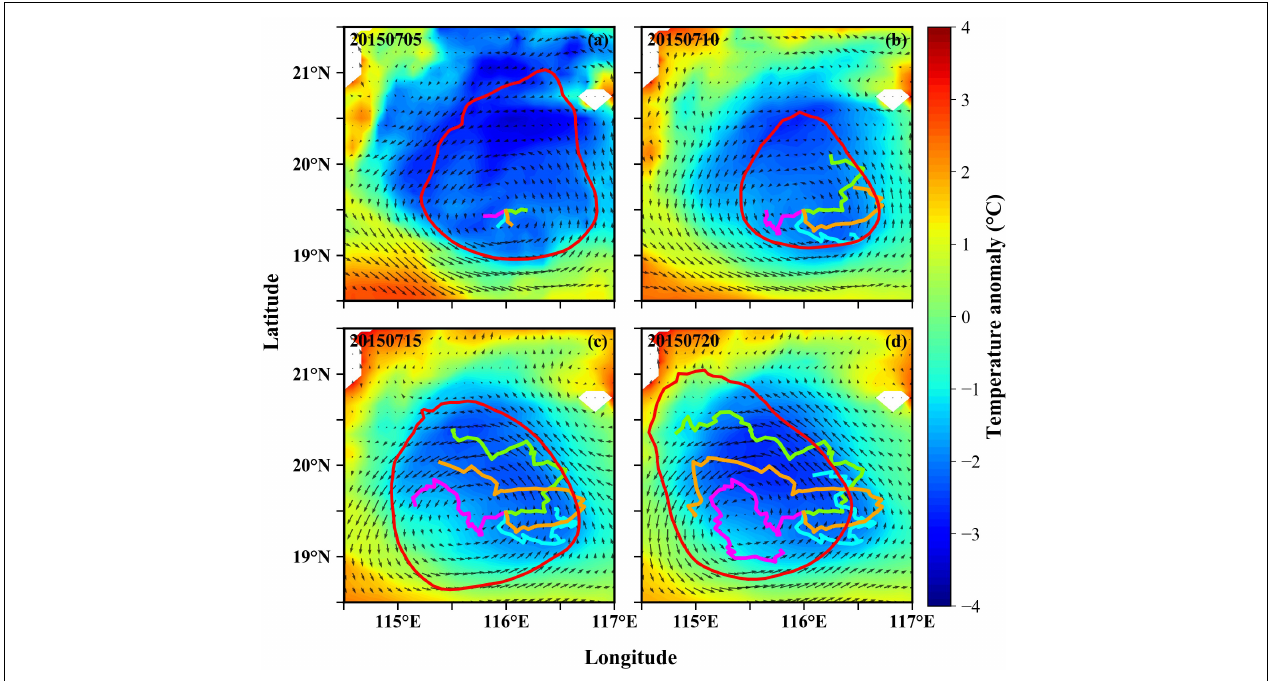
FIGURE 6 | (A–D) Show the position of gliders within the standard circle from July 5 to July 20, 2015, which are indicated by the different color dots. Red and blue rectangles represent areas that lack sufficient observation points.